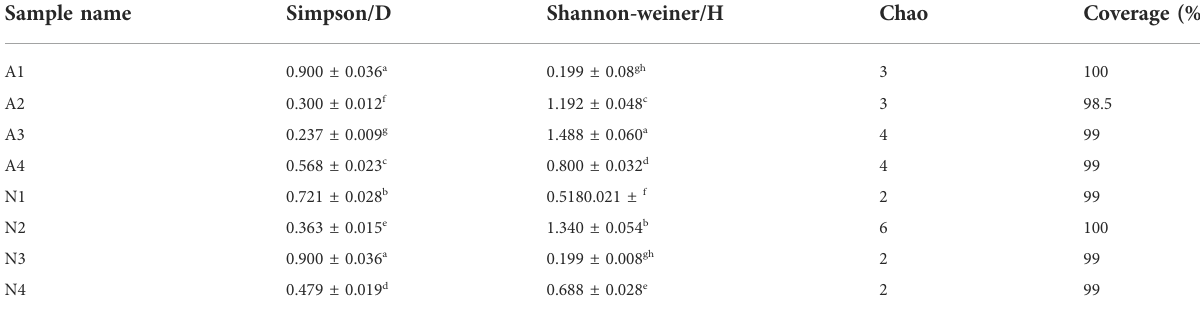
TABLE 2 Diversity level of anammox bacteria in the two groups.